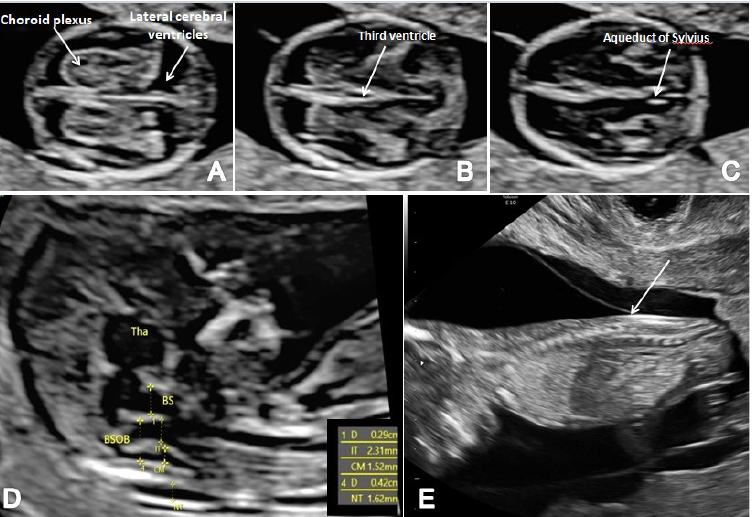
Figure 1. The FTAS protocol for CNS evaluation: ( A ) transverse view of the brain showing the contour and shape of the fetal skull, choroid plexus (arrow) and the filling of lateral cerebral ventricles (arrow); ( B , C ) further evaluation of the cerebral ventricular system, in transverse planes of the brain showing the third ventricle ( B ) and aqueduct of Sylvius ( C ) (arrow); ( D ) mid-sagittal view of the brain showing the thalamus (Tha) and the measurements for the brain stem (BS), the fourth ventricle (IT), cisterna magna (CM), the nuchal translucency (NT) and the brain stem–occipital bone ratio (BSOB); ( E ) longitudinal view of the spine regularity and underlying skin (arrow).